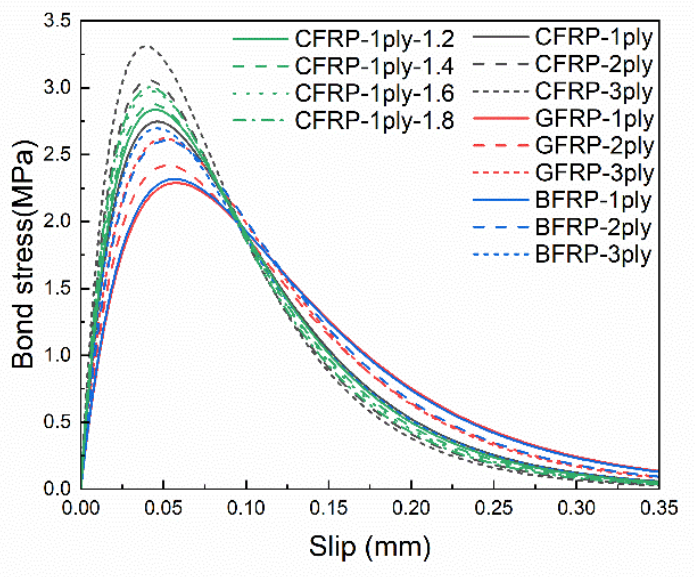
Figure 17. Bond–slip curves with different FRP stiffness.